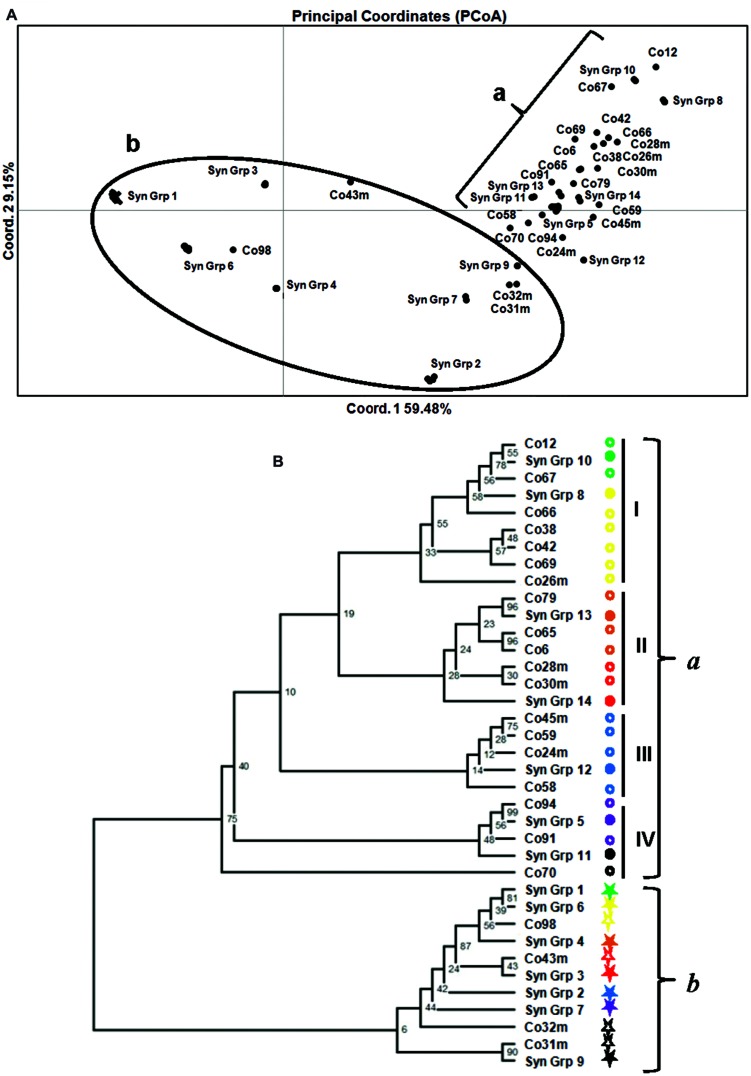
Genetic relationships based on 88 SNP markers among 172 M. roreri isolates collected from frosty pod rot affected areas of South and Central America. (A) Principal Coordinates Analysis based on the pairwise distance matrix. The plane of the first three main PCO axes accounted for 75.1% of total variation. First axis = 59.48% of total information, the second = 9.15%, and the third = 6.47%. (B) Cluster analysis and a consensus dendrogram were generated from the resulting distance matrix using the neighbor-joining algorithm (Saitou and Nei, 1987) and visualized using Figtree ver. 1.3.1 (Rambaut, 2009). Nei et al.’s (1983) genetic distance was calculated using microsatellite analyzer (Dieringer and Schlötterer, 2003) and 100 bootstrap replications were applied.